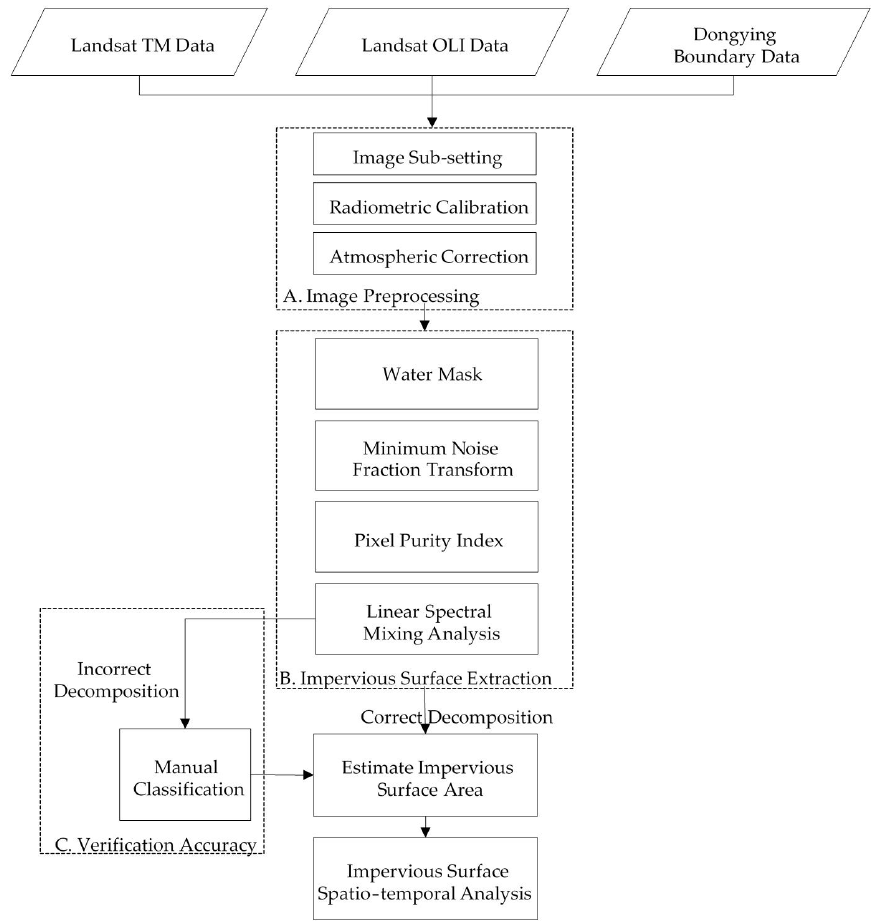
Figure 2. Dongying image after atmospheric correction by FLAASH module.